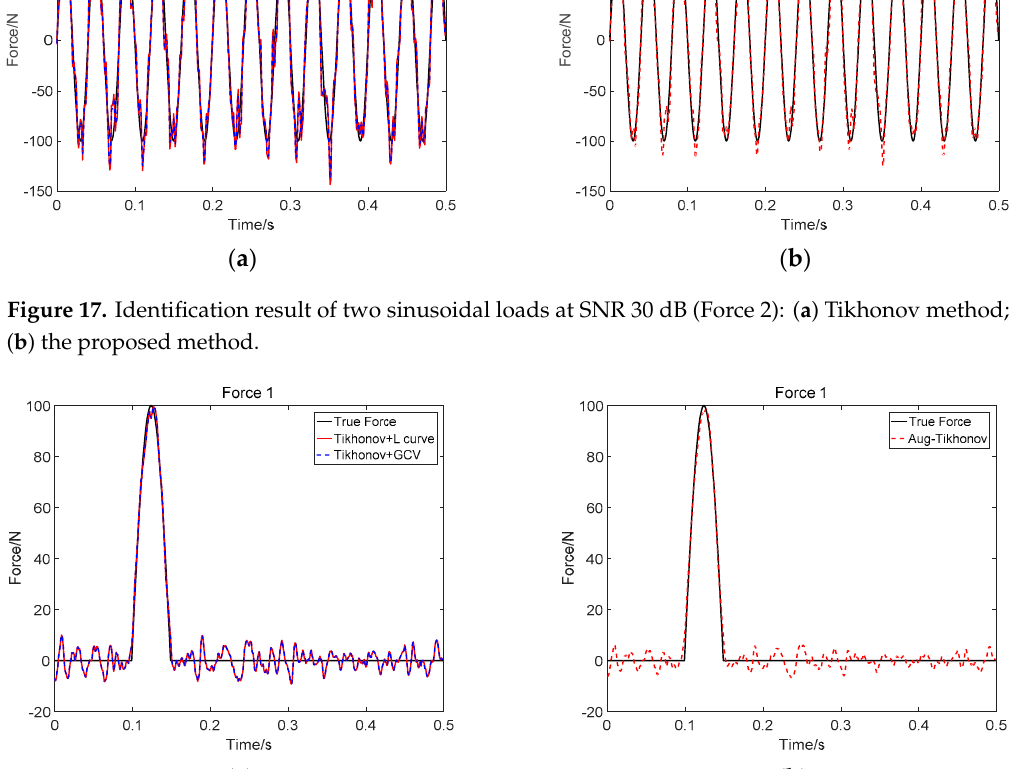
Figure 18. Identification result of two impact loads at SNR 40 dB (Force 1): ( a ) Tikhonov method; ( b ) the proposed method.